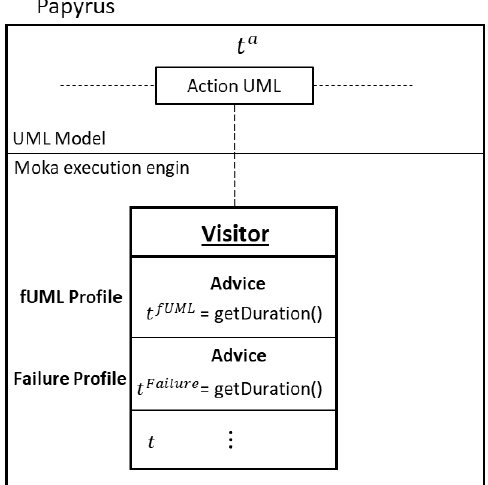
Figure 10. Task life duration from UML Profile.